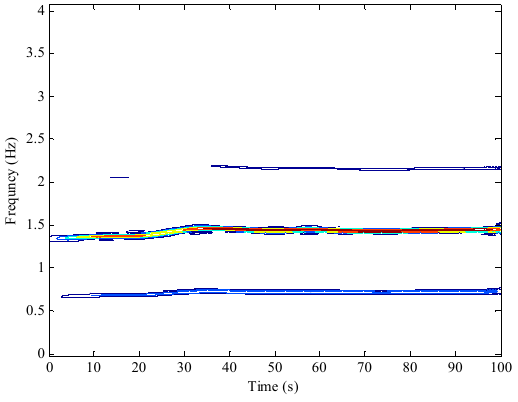
Figure 6. The SPWVD of the y axis gyroscope output.